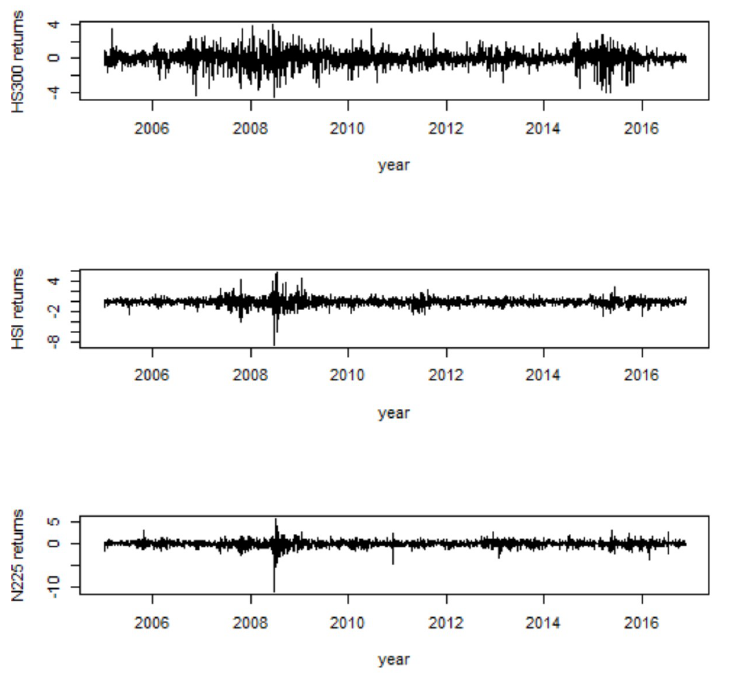
Fig. 1 Sequence diagram of the rate of return of the sample